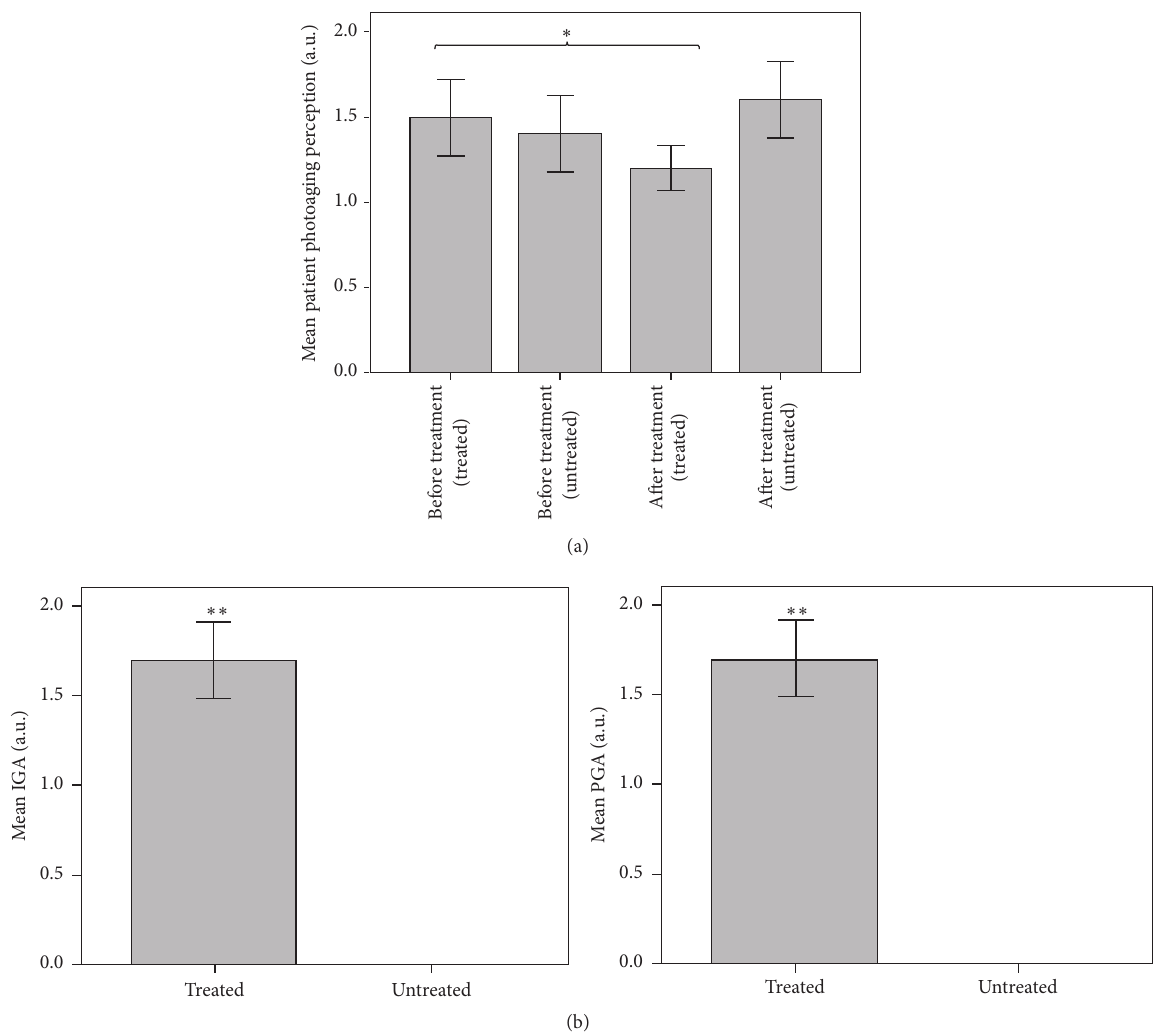
Figure 2: Perception of the degree of photoaging perceived by the patient showing an improvement on the self-perception of photoaging after treatment compared to baseline ( ∗ 𝑝 ≤ 0.05 ) (a). Patient and Investigator global assessment (b) demonstrating a significant difference between the improvement experienced by the treated hand compared to the untreated hand ( ∗∗ 𝑝 ≤ 0.01 ).